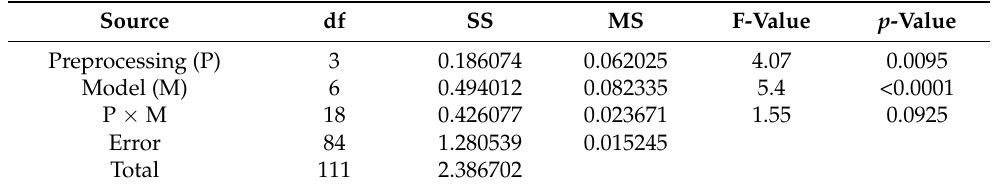
Table 3. Analysis of variance of percentage of correctly classified B. napus , GM B. napus , B. rapa and F1 hybrids from four different preprocessing and four different classification model using reflectance